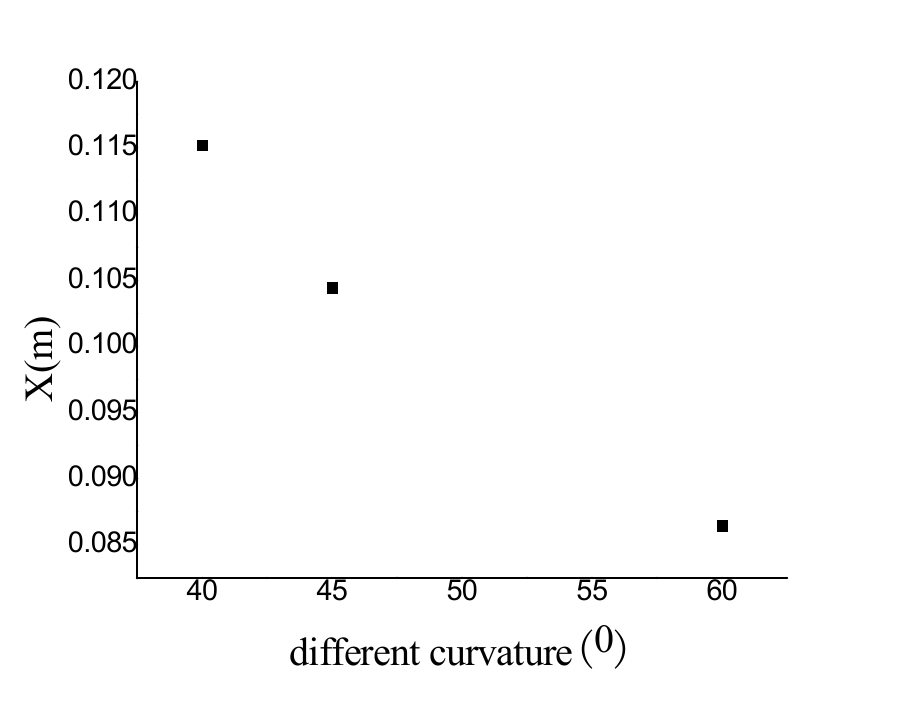
Figure 7. The change of quenching position with bend curvature.